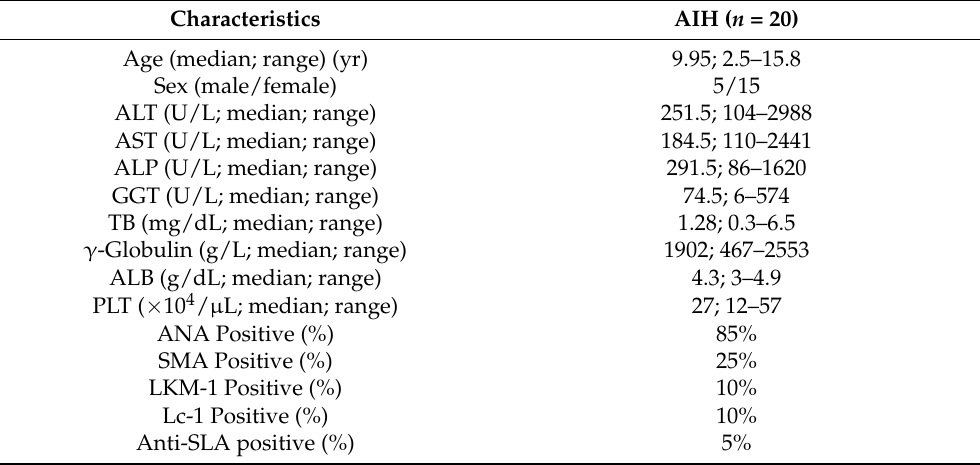
Table 1. Clinical and serological features of patients with AIH tested for autoantibodies.